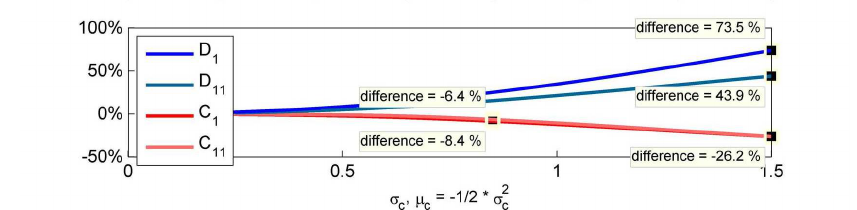
Figure 9. Effect of increasing uncertainty about ˜ c and price differences between random and constant